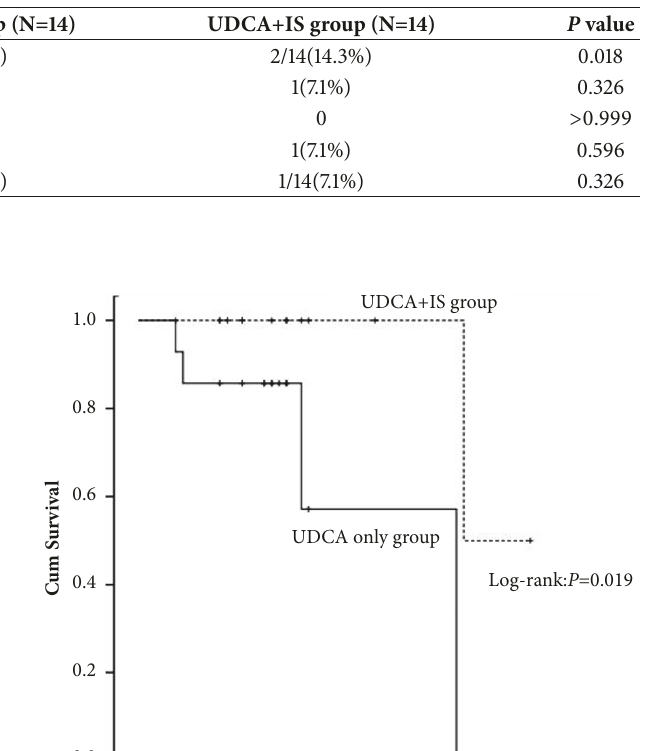
Table 5: Liver-related adverse events in the two groups.